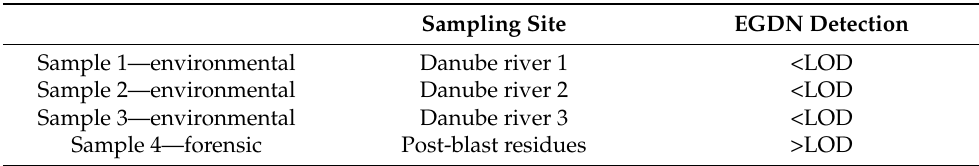
Table 3. Applicability of the developed